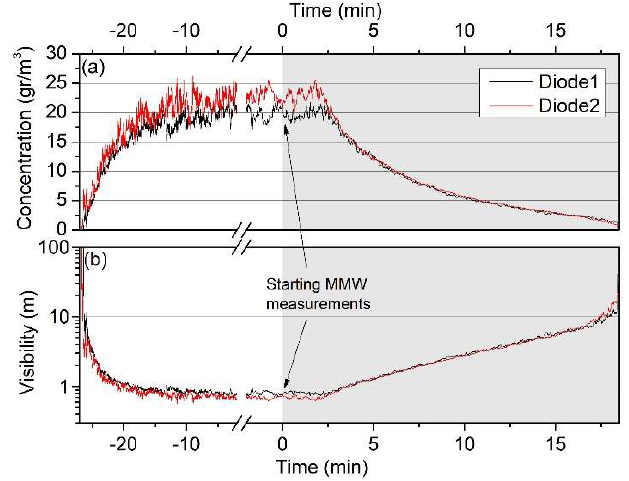
Figure 7. Typical results for the cloud concentration within the tunnel during a course of mmW mesurements: ( a ) and the corresponding visibility distance ( b ). The highlighted gray indicates the time at which mmW measurements were conducted.